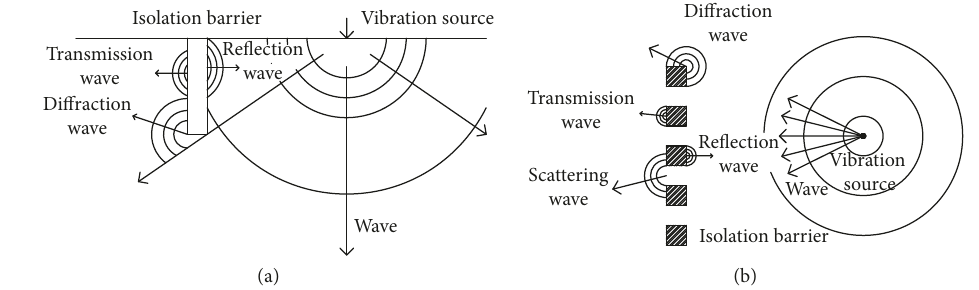
Figure 1: Types of the wave: (a) vertical view; (b) horizontal view.